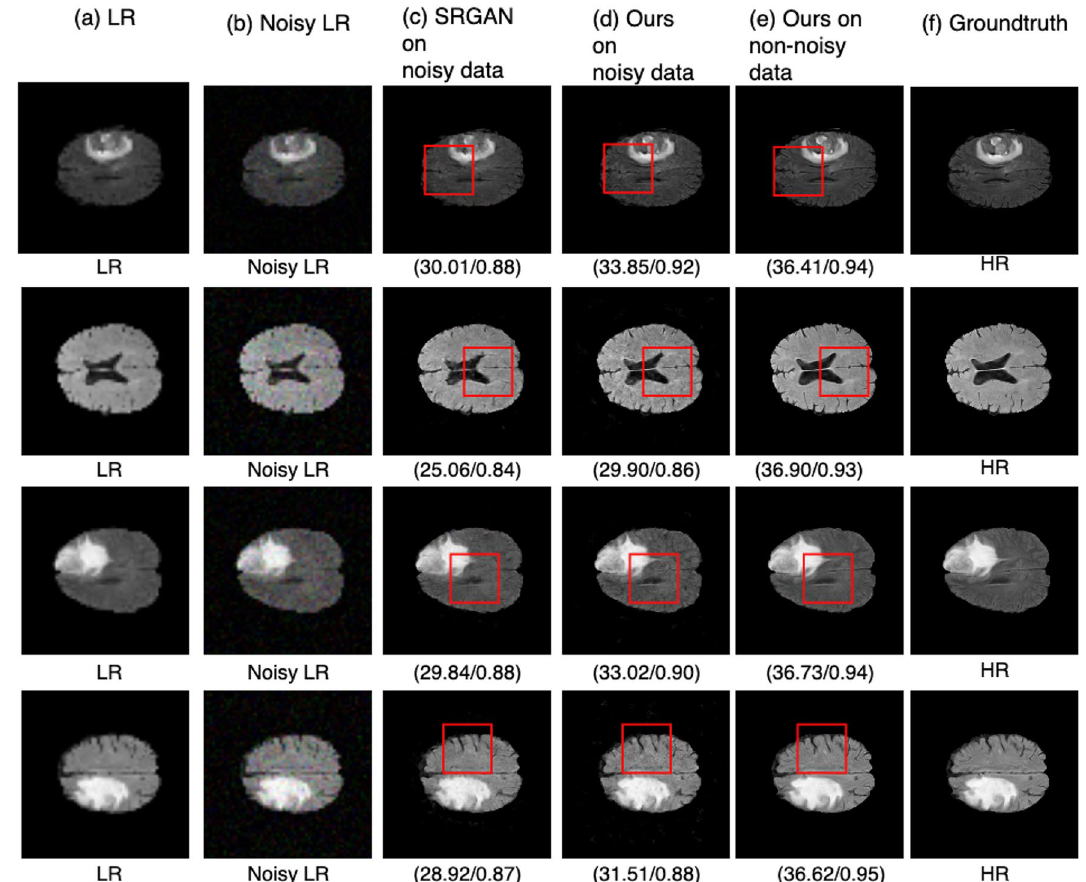
Figure 14. Results of super resolution for noisy MRI images. Column ( a ) shows the LR images ( 60 × 60 but scaled for uniform display), Column ( b ) shows the noisy LR images ( 60 × 60 but scaled for uniform display), column ( c ) shows the results for SRGAN 31 , column ( d ) shows the results for the proposed architecture, column ( e ) shows the results of proposed method on non-noisy images, column ( f ) shows ground truth HR images ( 240 × 240 ). Each row illustrates result of a single image. (SSIM/PSNR) score is shown for each image. Red box illustrates the degradation or improvement caused by each algorithm w.r.t ground truth HR